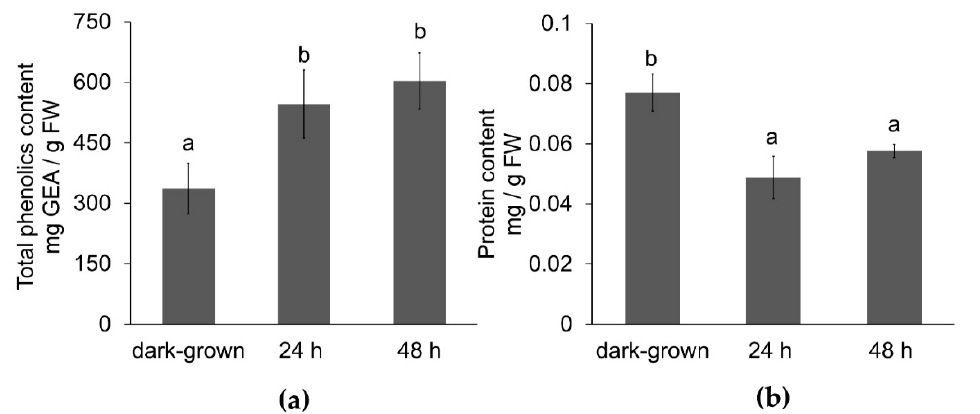
Figure 2. Total phenolic content ( a ) and protein content ( b ) in dark-grown chia microgreens and microgreens after exposure to light for 24 and 48 h. Data represent mean values from three experiments with five replicates (n = 15). The error bars show standard deviation (SD). Different letters signify values that are statistically different at p ≤ 0.05 according to Fisher’s LSD test.